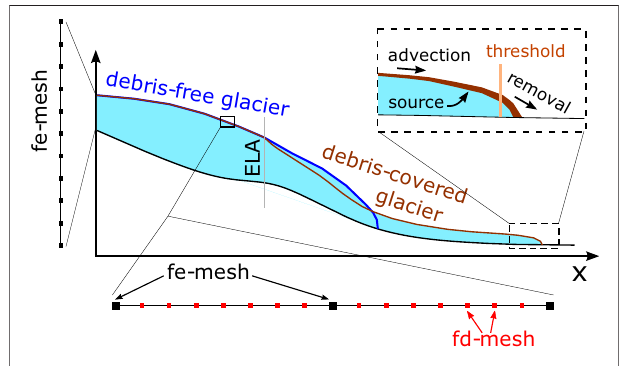
FIGURE 3 | Schematic representation of our modelling approach. Blue boxes indicate essential equations (with order of execution). Important state variables are in green. Grey boxes indicate variables requiring an initialisation. Climate forcing is kept constant (orange box).